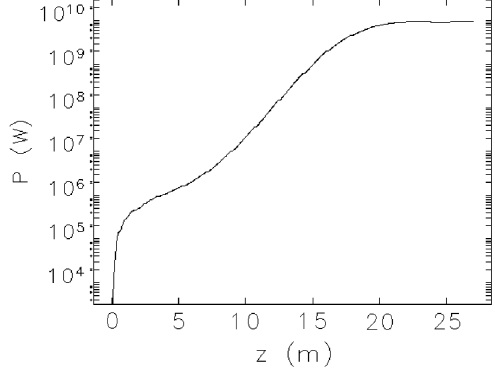
FIG. 9. FEL power evolution along the undulator.